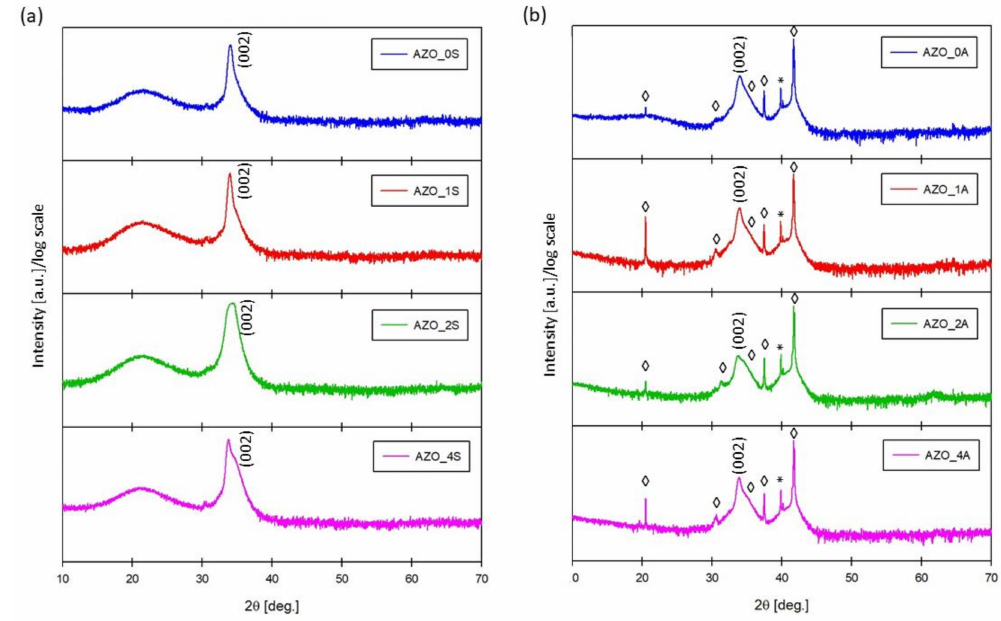
Figure 1. X-ray diffraction (XRD) spectra of Al-doped ZnO (AZO) films deposited ( a ) on silica (series AZO_xS); ( b ) on Al 2 O 3 (series AZO_xA). (hkl) reflections of AZO [18] are indicated, while ♦ labels the peaks of Al 2 O 3 substrate and asterisks * the unattributed peaks.